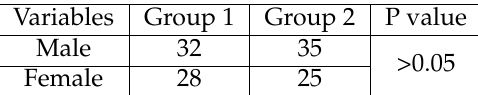
Table 1. Demographic characteristics.